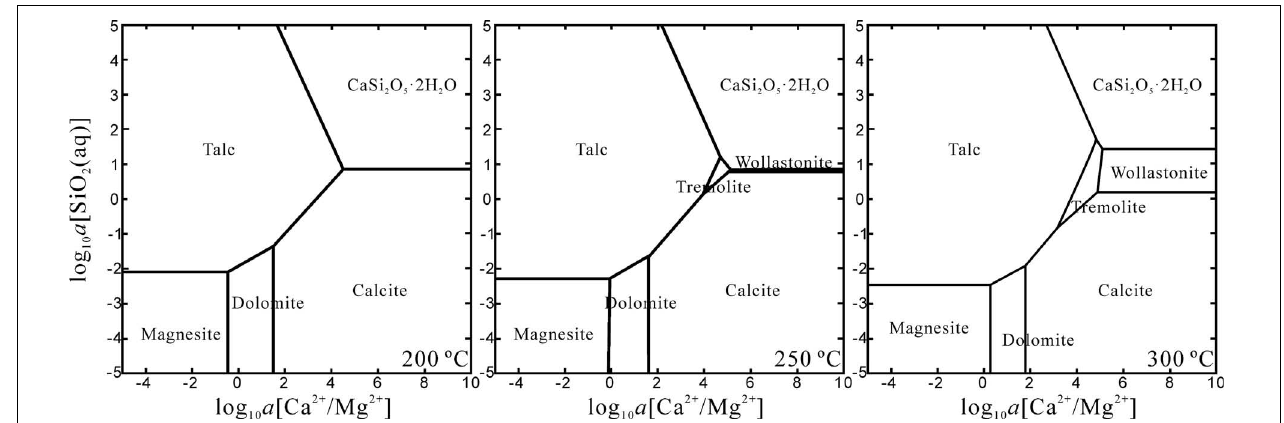
FIGURE 12 | The activity diagrams of the Ca-Mg-Si-H-O-C system at 200–300 ◦ C and 50 MPa. The diagrams are calculated with Geochemist’s Workbench (Bethke, 1996) using the Lawrence Livermore National Laboratory database. Although the upper limit of temperature is restricted to 300 ◦ C, the change of the equilibrium area of tremolite with temperature suggests that it could probably become the most stable phase with relatively higher SiO2(aq) activity and log 10 a [Ca 2 + ]/[Mg 2 + ] with higher